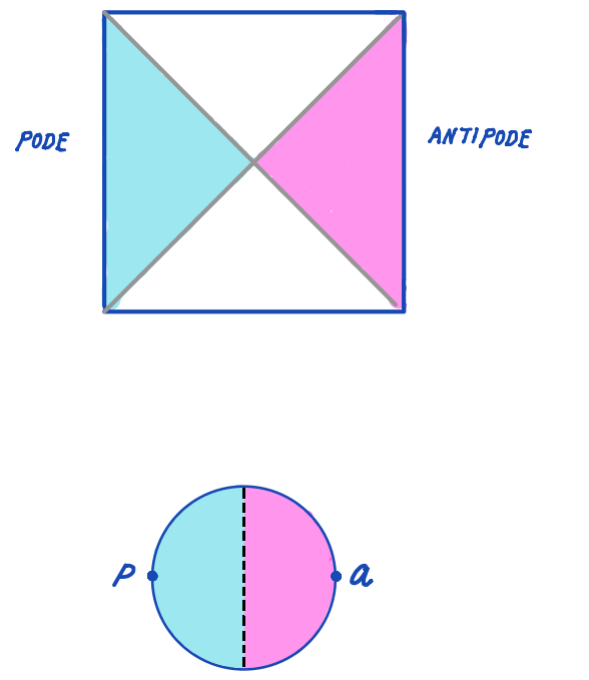
Figure 4. Upper panel : Penrose diagram for higher-dimensional de Sitter space. Static patches come in pairs and the center of these patches are referred to as the pode and the antipode. Lower panel : the geometry of the t = 0 slice of de Sitter spaceis a sphere with the pode at one pole and the antipode at the other. The dashed surface midway between the pode and antipode is the bifurcate horizon. 2.2. Where Is the